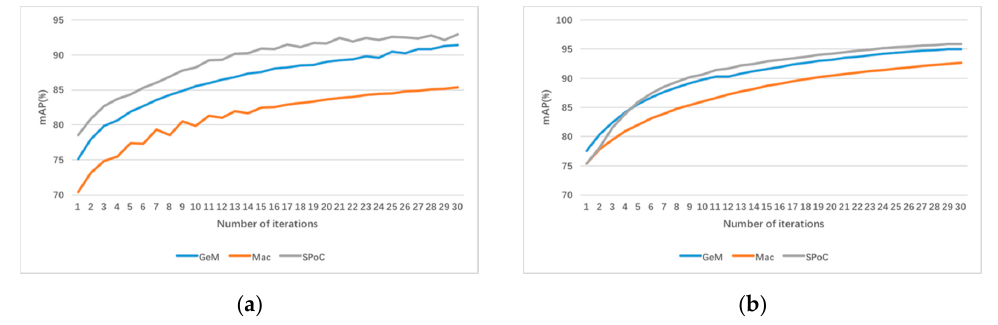
Figure 6. The pooling methods. Evaluation is performed with VGG16 ( a ) and ResNet50 ( b ) on PatternNet datasets. The curve represents the evolution of mAP in the training iteration.